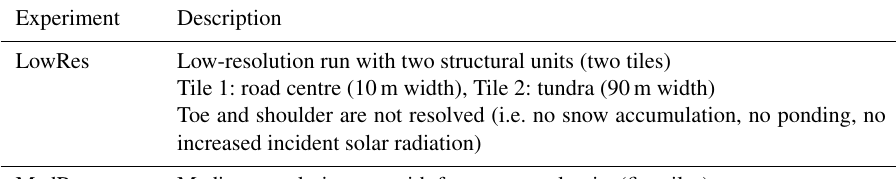
Table 3. Description of performed simulation experiments with